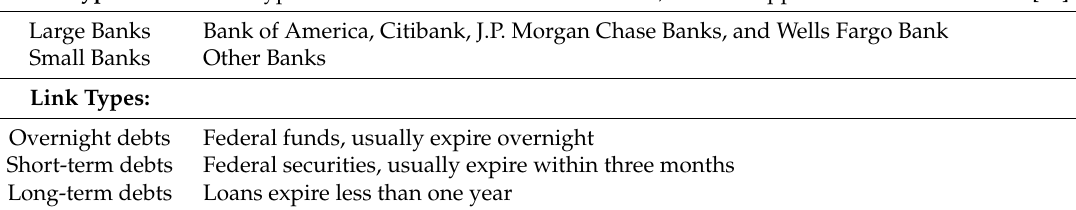
Table 1. Interbank network